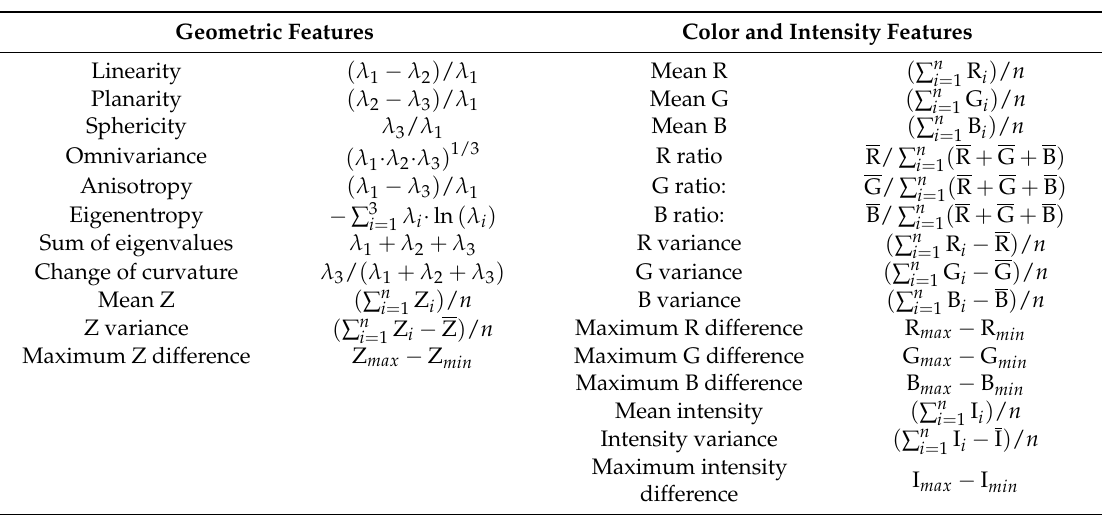
Table 1. Three types of feature